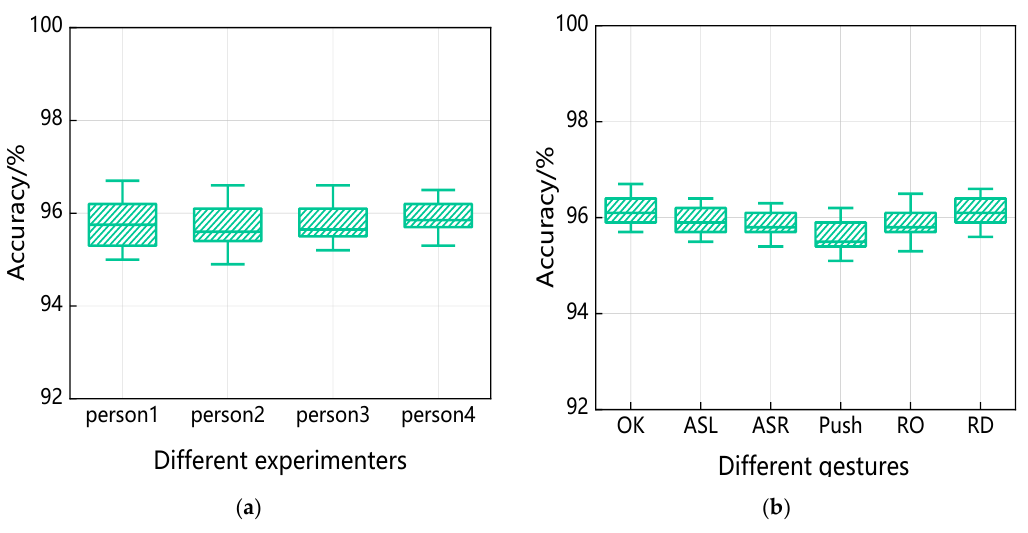
Figure 13. The effect of cross-targeting on gesture recognition: ( a ) Effect of different experimenters on gesture recognition. ( b ) Effect of the same experimenter on different gestures recognition.